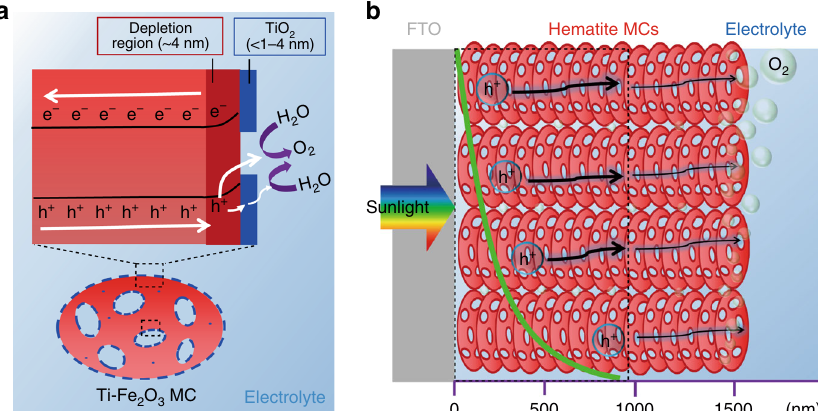
Fig. 7 Proposed charge carrier dynamics in thick hematite MC fi lm. a Illustration of the charge transfer at the SEI of Ti – Fe 2 O 3 MC. b Illustration of the hole transport in the optimized Ti – Fe 2 O 3 MC photoanode with fi lm thickness of 1500